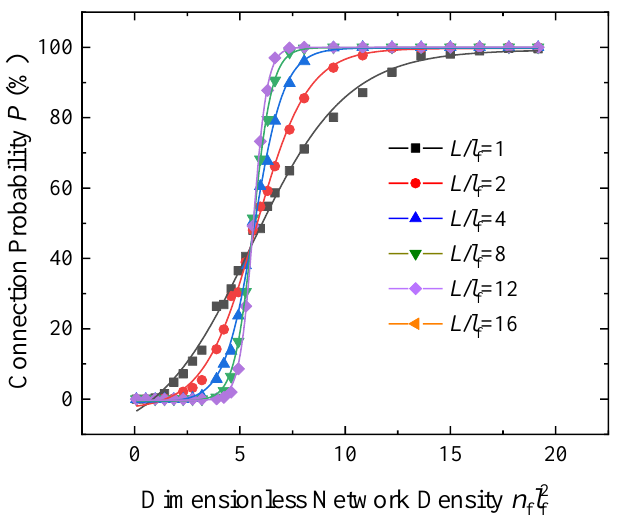
Figure A3. Effect of the relative size of RAE L / l f on the connection probability P of the networks.